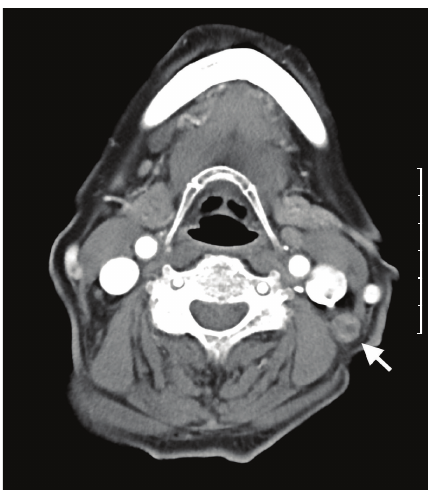
Figure 1: A cervical Computed Tomography scan at the initial examination showed multiple swollen cervical lymph nodes. The arrow indicates one of the swollen lymph nodes.